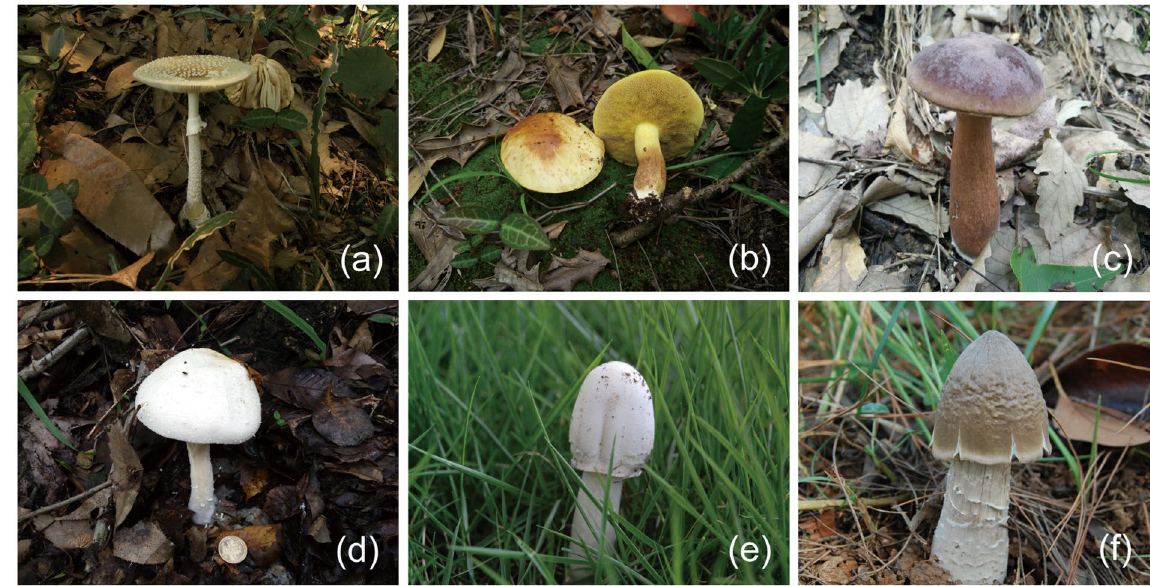
Figure 1. Photographs of the fruit bodies of Amanita pantherina ( a ), Suillus placidus ( b ), Tylopilus felleus ( c ), Agaricus flocculosipes ( d ), Chlorophyllum molybdites ( e ), and Termitomyces albuminosus ( f ).